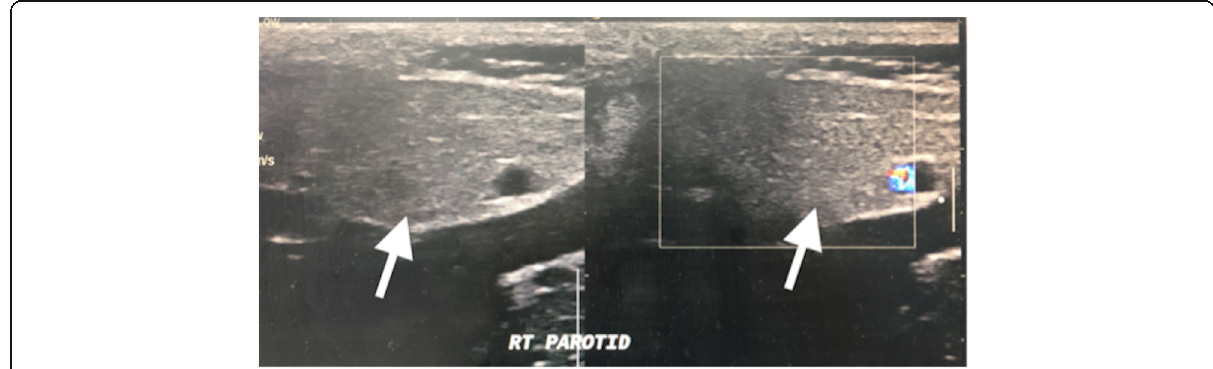
Fig. 4 Ultrasonography shows normal right parotid gland with homogenous echogenicity. The parotid duct was not dilated and no residual calculus are